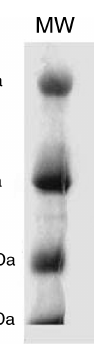
Figure 4. Purification of recombinant Rbp18 by affinity chromatogra-